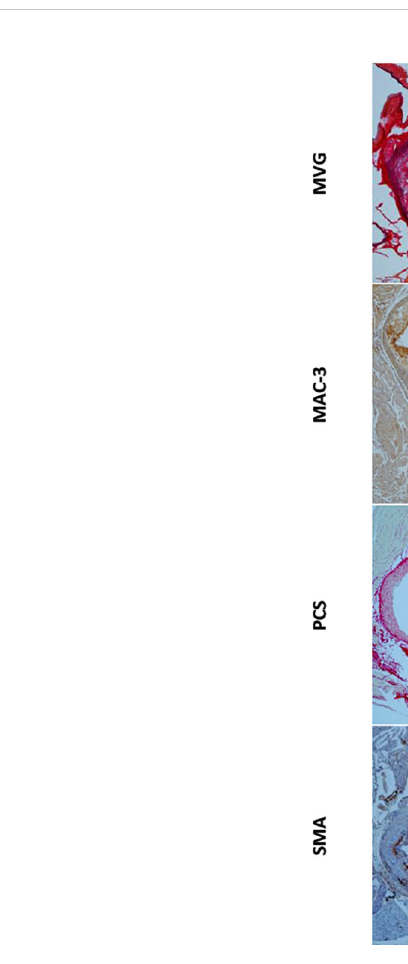
FIGURE 5 Aortic sinus sections 2 weeks post infection and mock infection. Representative images of MVG, MAC-3, Picrosirius Red (PCS) and smooth muscle actin (SMA) stained aortic sinus sections from S. pneumoniae infected (n=12) and PBS mock infected (n=11) ApoE -/- mice, using the optimised model as described in Figure 4. Scale bars represent 400